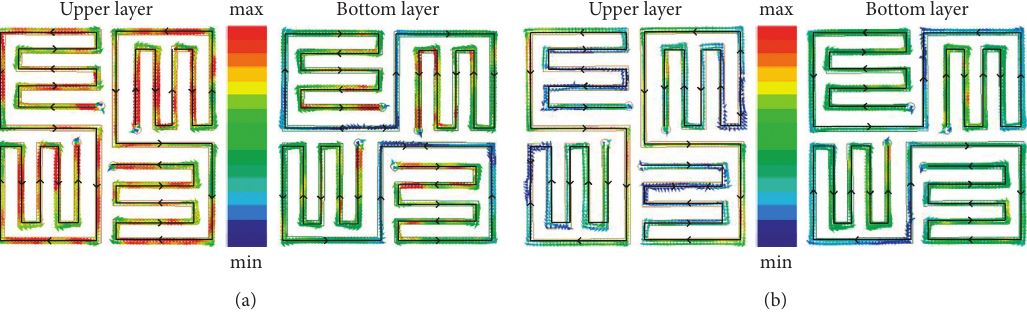
Figure 6: Surface current distributions at two resonant frequencies: (a) 1.12GHz; (b) 2.52GHz.